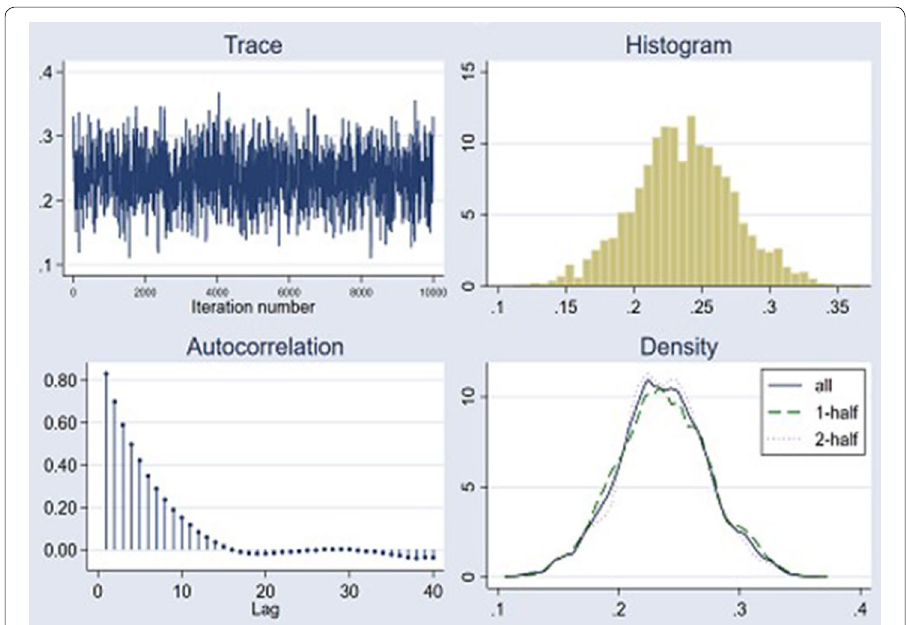
Fig. 1 MCMC residual diagnostics for